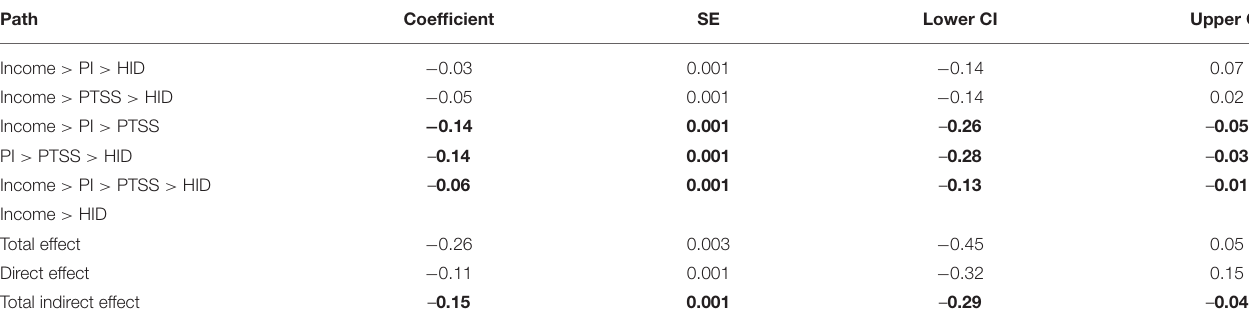
TABLE 2 | Total, direct and indirect effects of income, paternal involvement, PTSS and maternal harsh and inconsistent